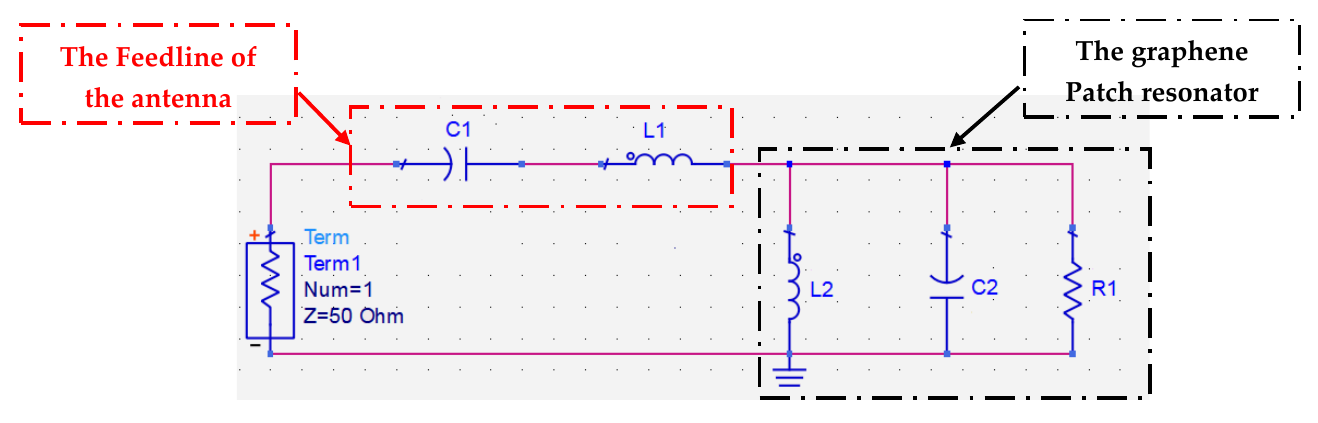
Figure 4. ADS equivalent circuit model of the proposed graphene antenna .